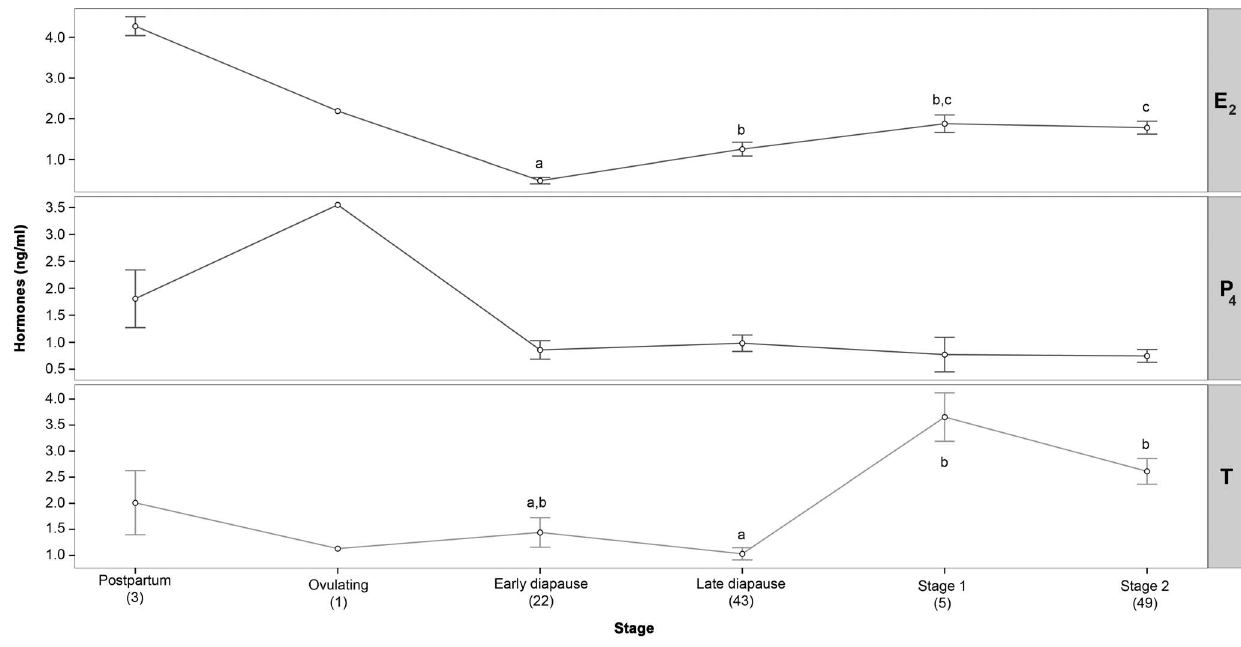
Figure 4. Mean plasma steroid hormone concentrations at different reproductive stages of femalesRhizoprionodontaylori . Letters depict statistical dissimilarity using pairwise Wilcox post-hoc test. Missing letters in E 2 and T graphs represent groups with sample sizes too small for statistical analysis. Progesterone levels were not significantly different among reproductive stages. Numbers in brackets denote sample size.